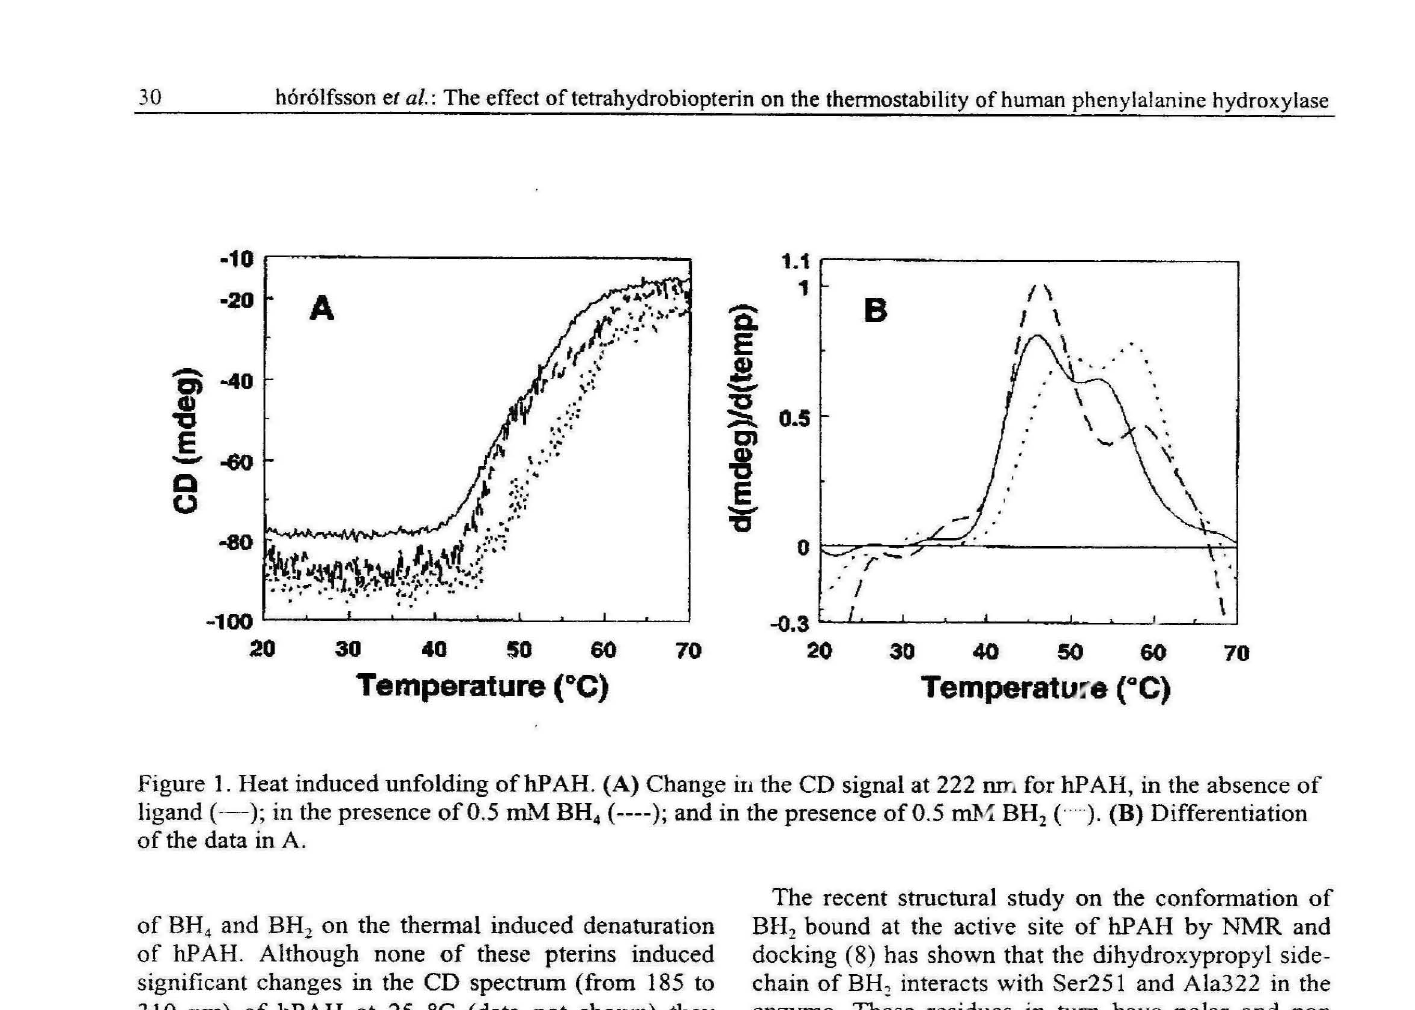
Figure 1. Heat induced unfolding of hP AH. (A) Change ill the CD signal at 222 nm for hP AH, in the absence of ligand (--); in the presence of 0.5 mM BH4 (----); and in the presence of 0.5 m.M: BH2 (). (B) Differentiation of the data in A.